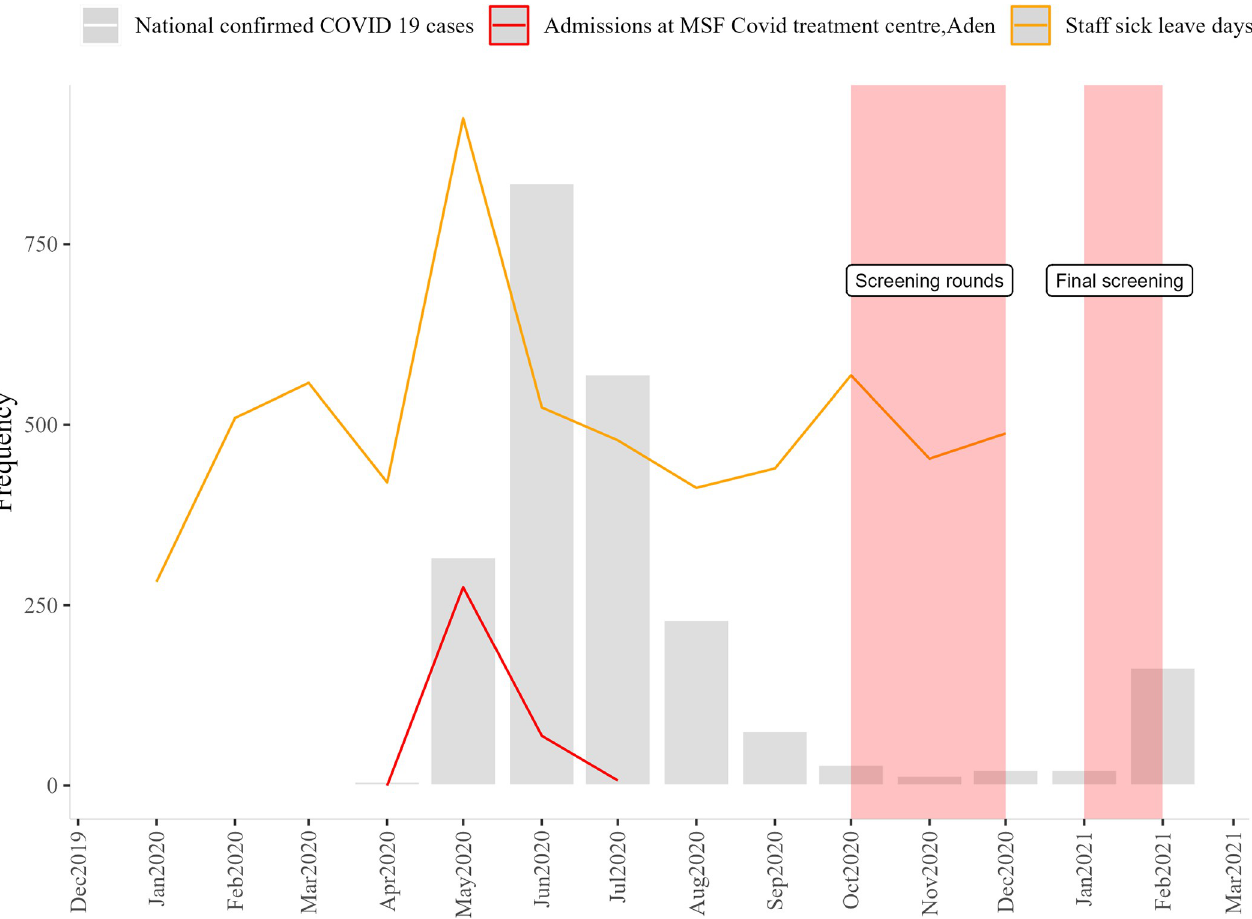
Fig 1. Yemen COVID-19 epi curve, number of admissions at MSF covid19 treatment center and number of sick leave days taken by MSF staff in Aden Trauma Center—Sep 2020 and Jan 2021.